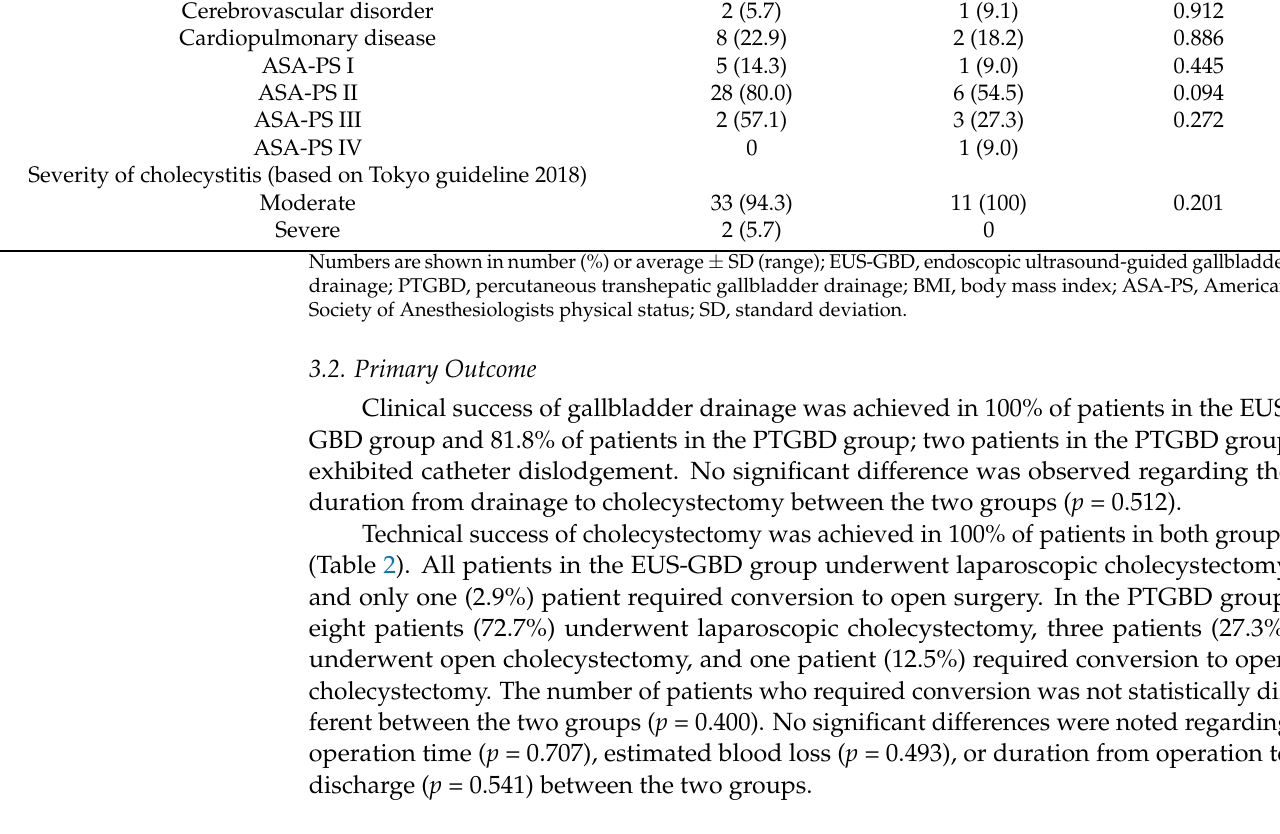
Table 2. Comparison of drainage procedure